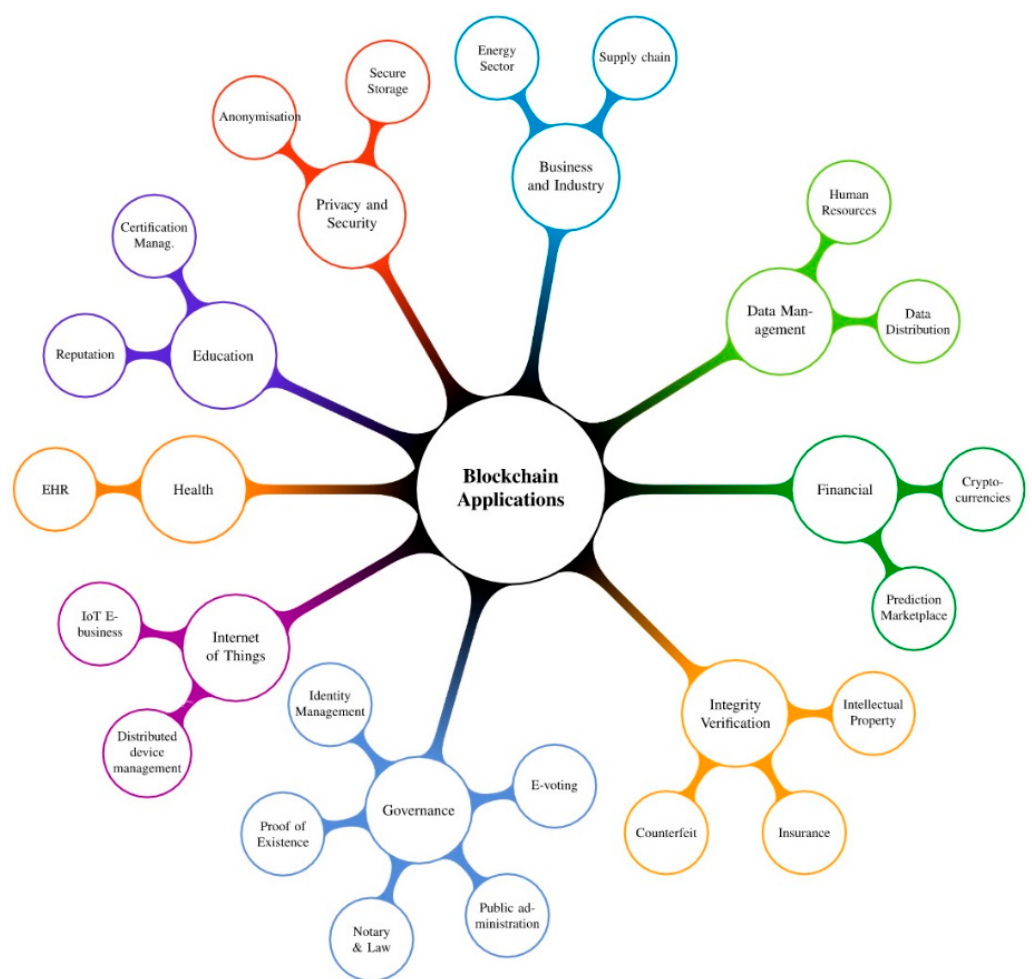
Figure 1. Mindmap abstraction of different types of blockchain applications. Source: Casino, F., Dasaklis, T.K., Patsakis,